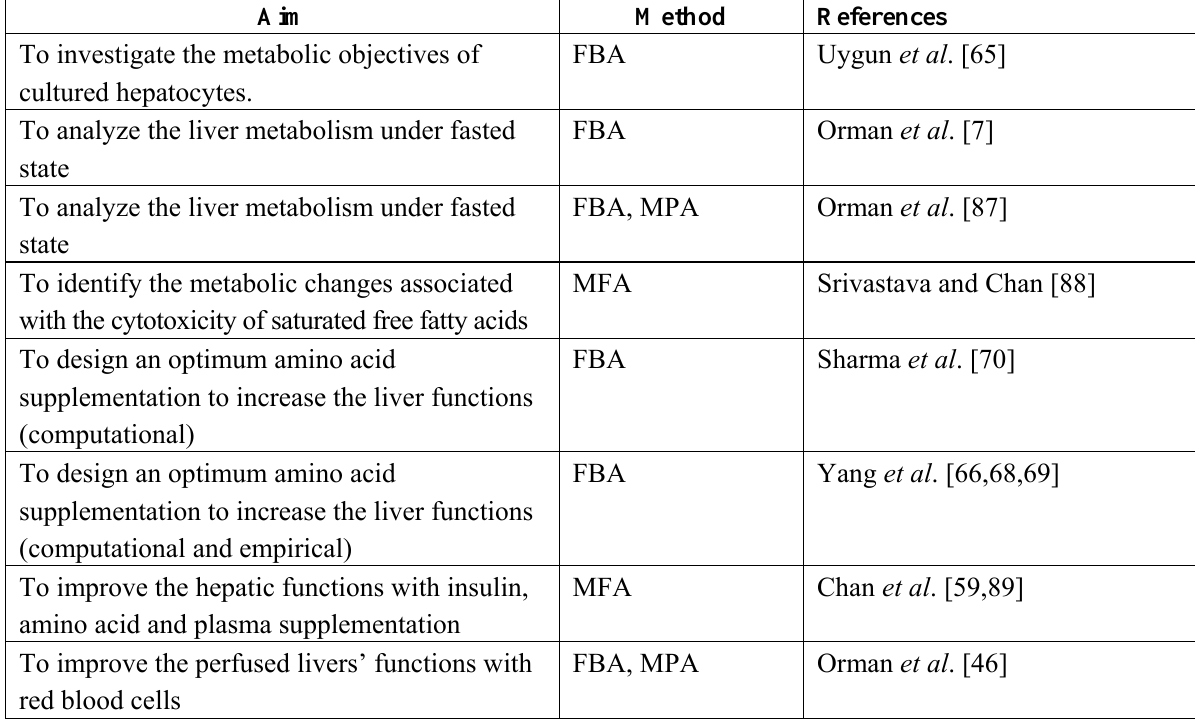
Table 1. Published studies where steady state hepatic fluxes have been determined. FBA: Flux balance analysis, MPA: Metabolic pathway analysis, MFA: Metabolic flux